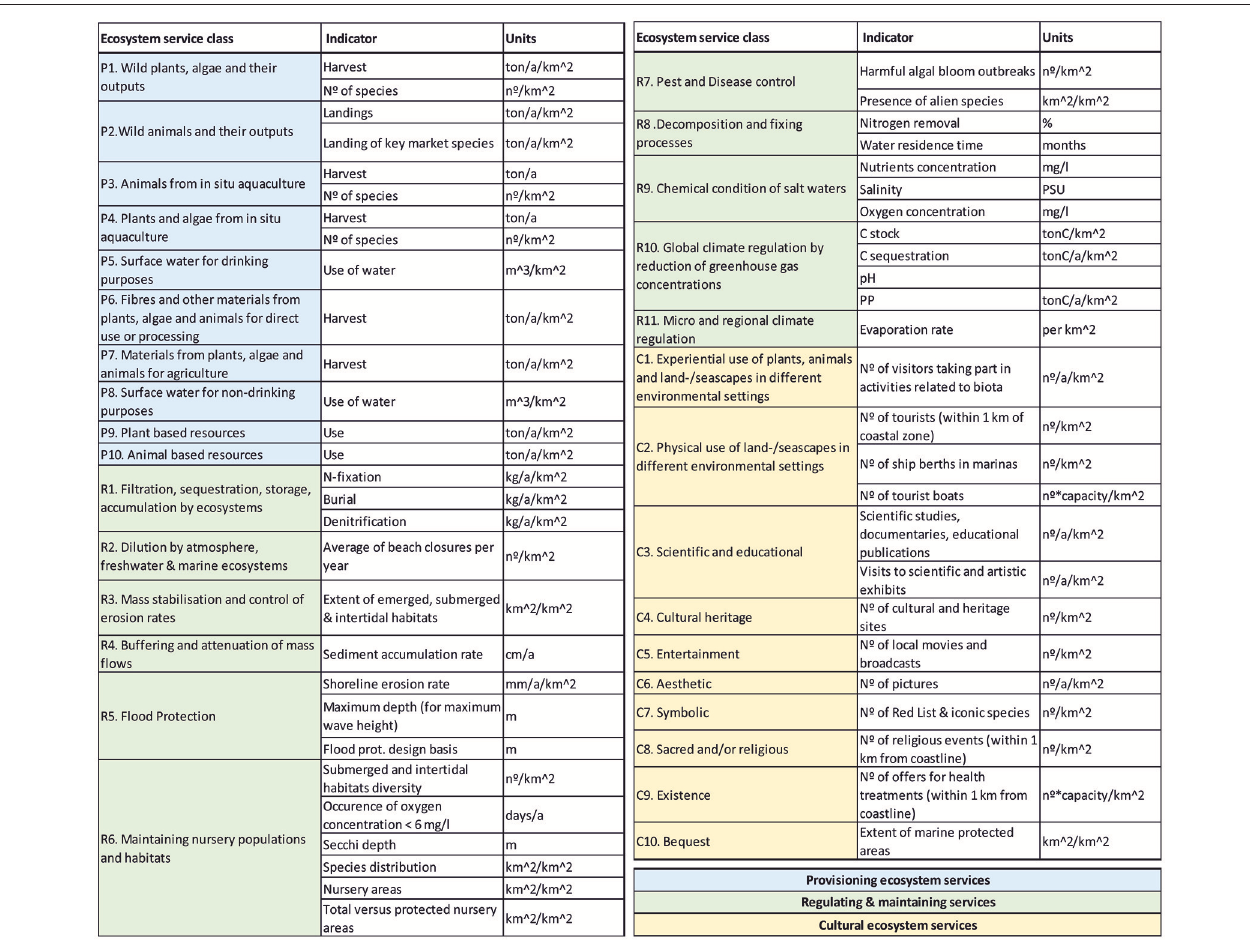
FIGURE 3 | Sub-division of ecosystem services into sections and classes as well as the associated indicators including units. The table is modified and extended based on CICES (Haines-Young and Potschin, 2013) and MAES (Maes et al.,